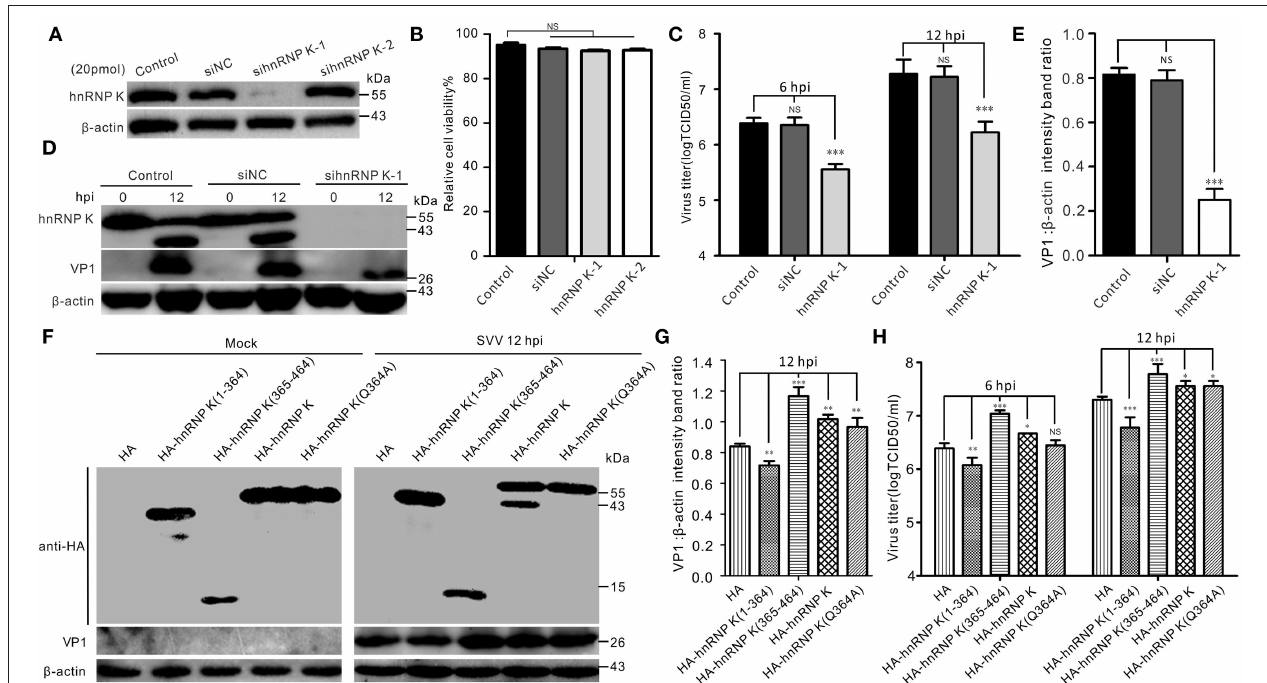
FIGURE 5 | The expression of hnRNP K is essential for SVV replication. (A) BHK-21 cells in six-well plates were mock-transfected or transfected with 20 pmol of hnRNP K-siRNA and negative control (NC)-siRNA for 48h. The expression of hnRNP K was assessed by Western blotting. (B) The viability of si-RNA transfected BHK-21 cells was analyzed using CCK-8 assay. Error bars indicate the mean ± SD of three independent experiments (NS, not significant). (C) BHK-21 cells transfected with siRNA for 48h were infected with SVV (MOI = 1), and the virus productions were assessed by TCID 50 . Error bars indicate the mean ± SD of three independent experiments (NS, not significant). (D) BHK-21 cells transfected with siRNA for 48h were infected with SVV (MOI = 5), and the expression of VP1 was assessed by Western blotting. (E) The ratios of VP1 normalized against β -actin of three independent experiments of (C) (* P < 0.05; *** P < 0.001). Graphs of quantification analyzed with Image J. Data are represented by mean ± standard deviation (SD). (F) BHK-21 cells were transfected HA-hnRNP K (1–364), HA-hnRNP K (365–464), HA-hnRNP K, HA-hnRNP K (Q364A), and empty HA vector. At 24 hpt, the cells were infected with SVV (MOI = 5), and the cell lysates were subjected